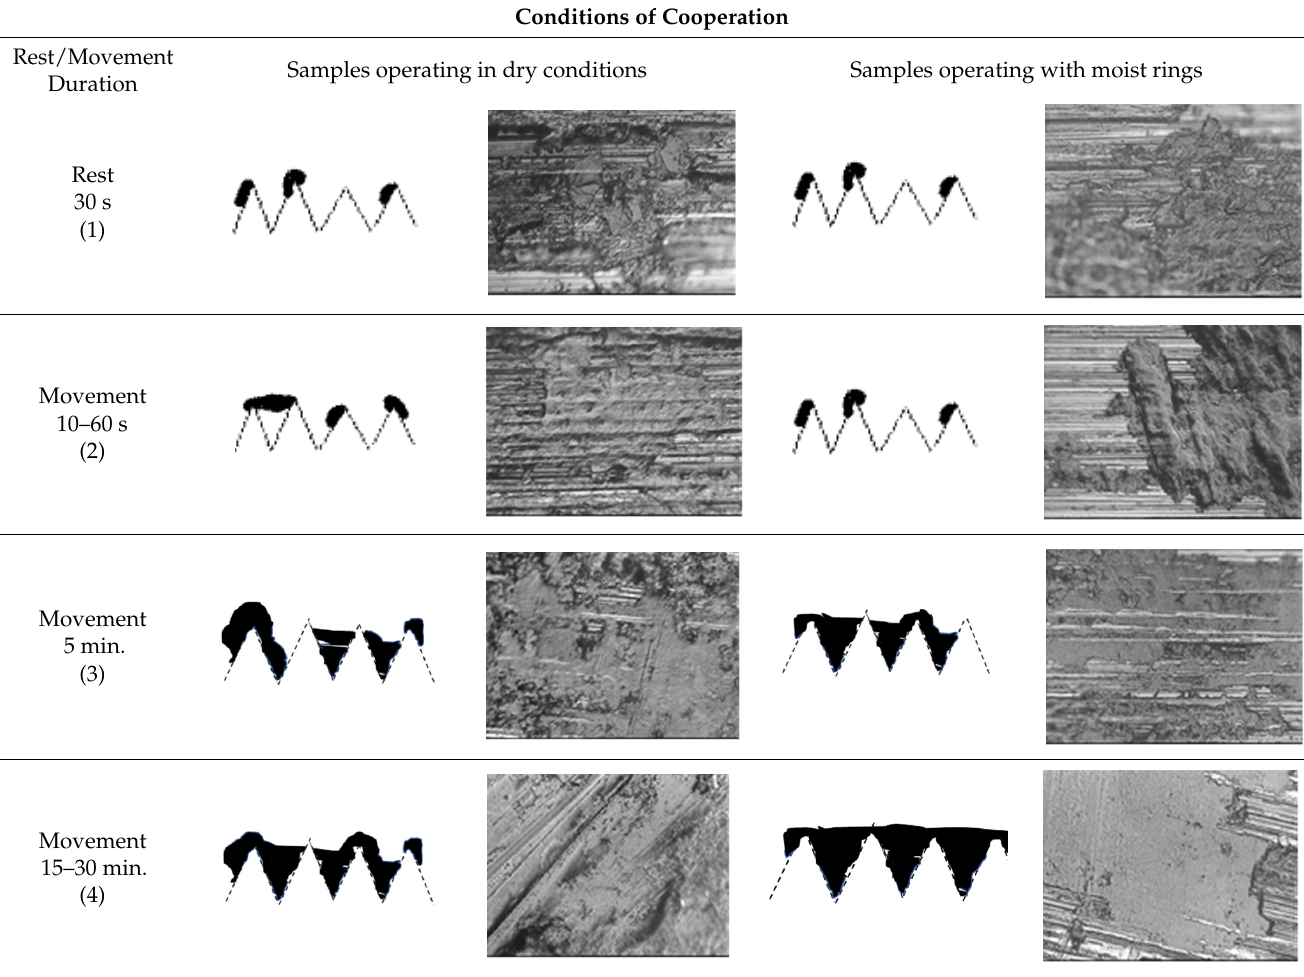
Table 4. Schematic diagram of the formation of a graphite sliding layer on the surface of a steel sample and photographs of its surface after interaction with a dry and moist counter sample of expanded graphite (roughness group I).